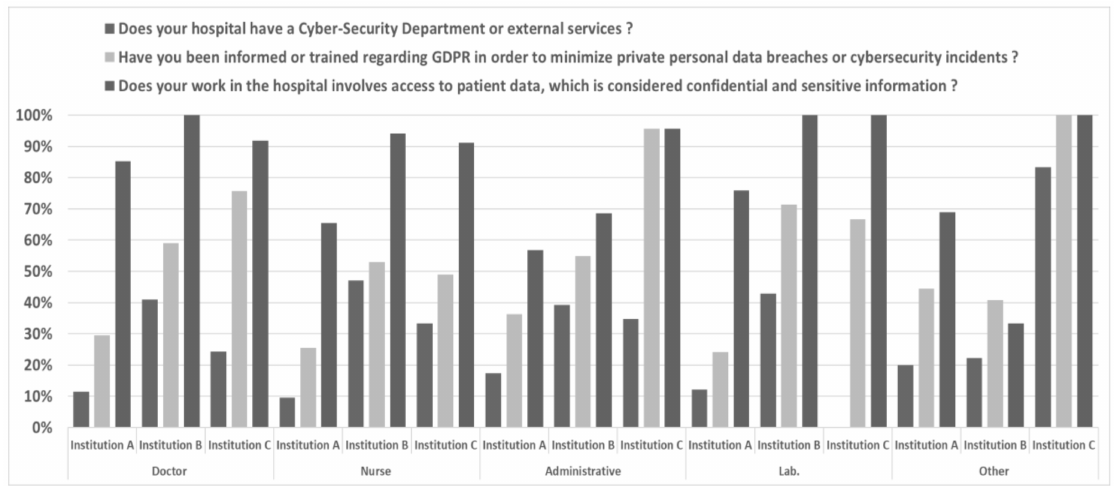
Figure 5. Awareness of Non-ICT personnel on legal aspects, privacy and cybersecurity